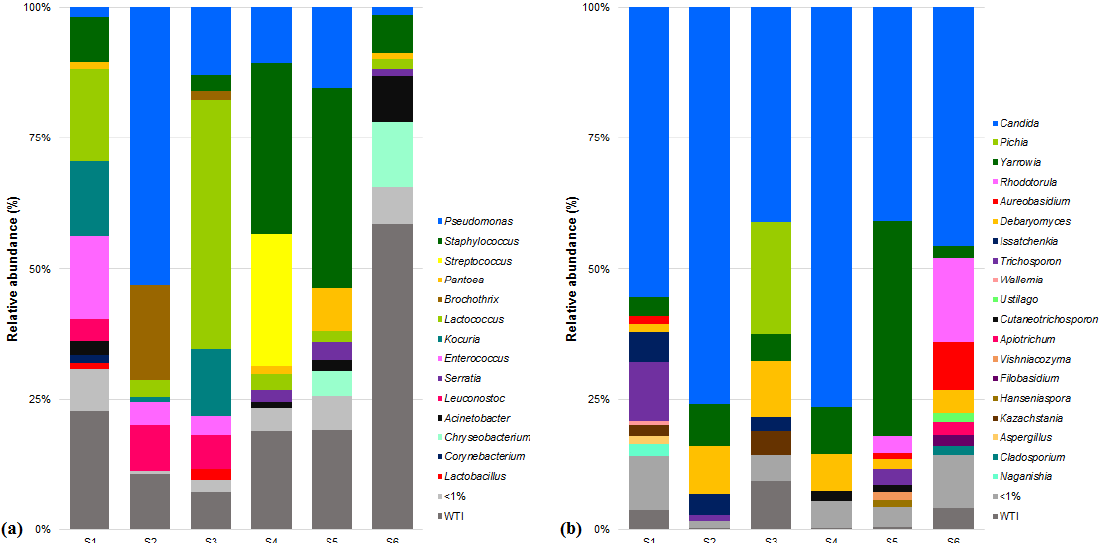
Figure 2. Relative abundances (%) of dominant sequences (>1%) assigned to genus level identified in raw ewes’ milk DNA samples based on partial sequence analysis of the ( a ) V3–V4 and ( b ) Internal Transcribed Spacer 2 regions of the rRNA gene. WTI refers to percentage of sequences without taxonomic attribution to the specified taxonomic level.